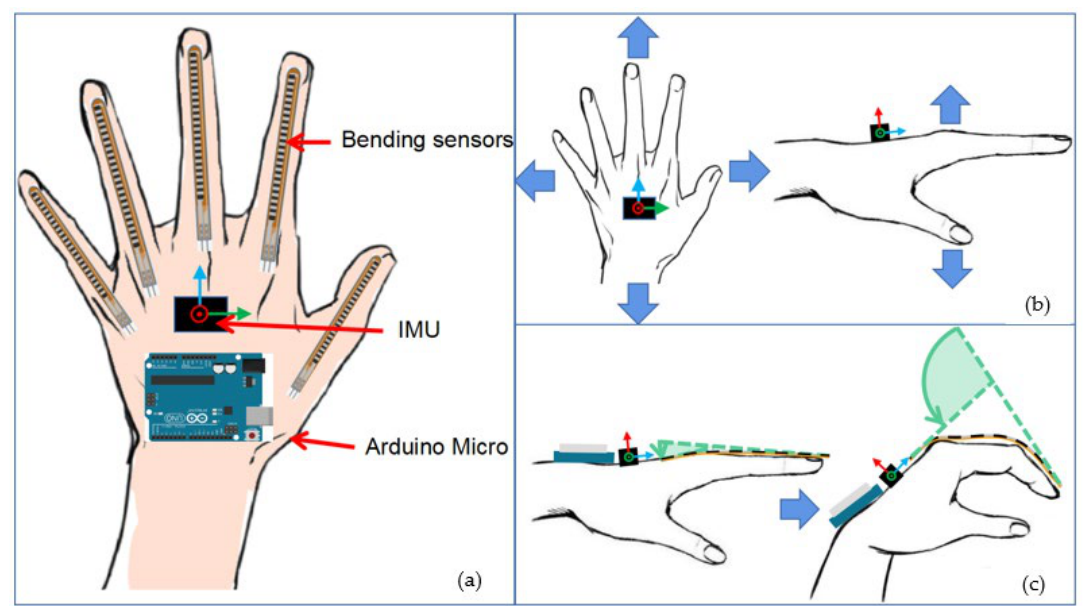
Figure 5. Architecture of the system.